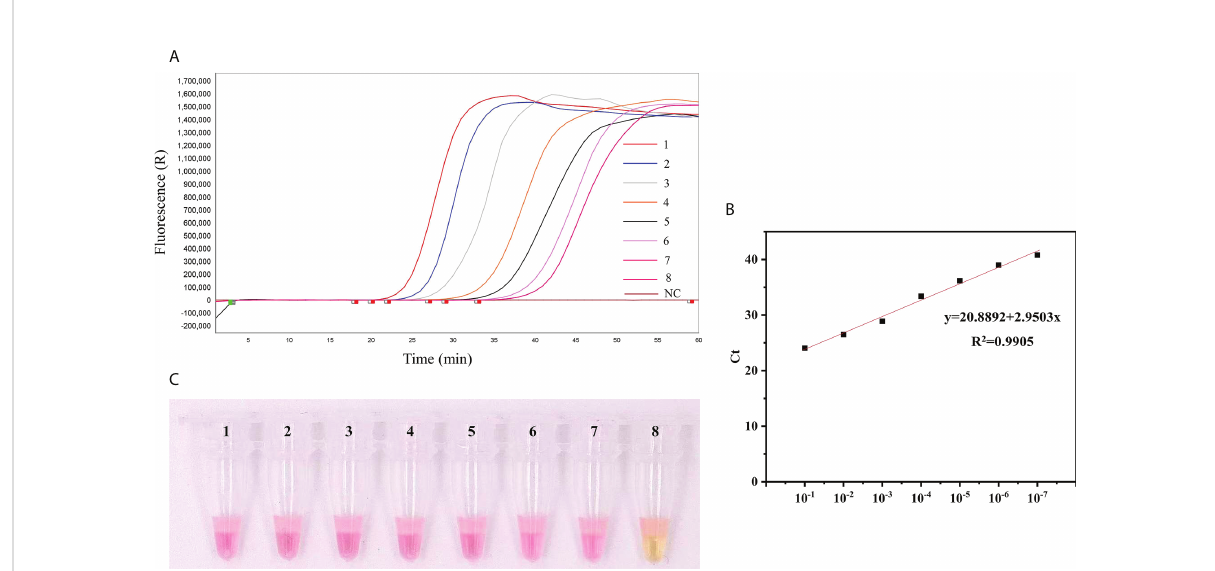
FIGURE 2 Comparison of the sensitivity of qLAMP and visual LAMP. (A) Results of qLAMP analysis. Lanes 1-8: Reaction results from a 10-fold serial dilution of T. gondii positive standard plasmids from 9.2 × 10 7 to 9.2 × 10 0 copies/µL per reaction; Lane 9: NC (negative control, nuclease-free water), (B) Standard curve of qLAMP, (C) Results of visual LAMP analysis. Lanes 1-8: 9.2 × 10 7 to 9.2 × 10 0